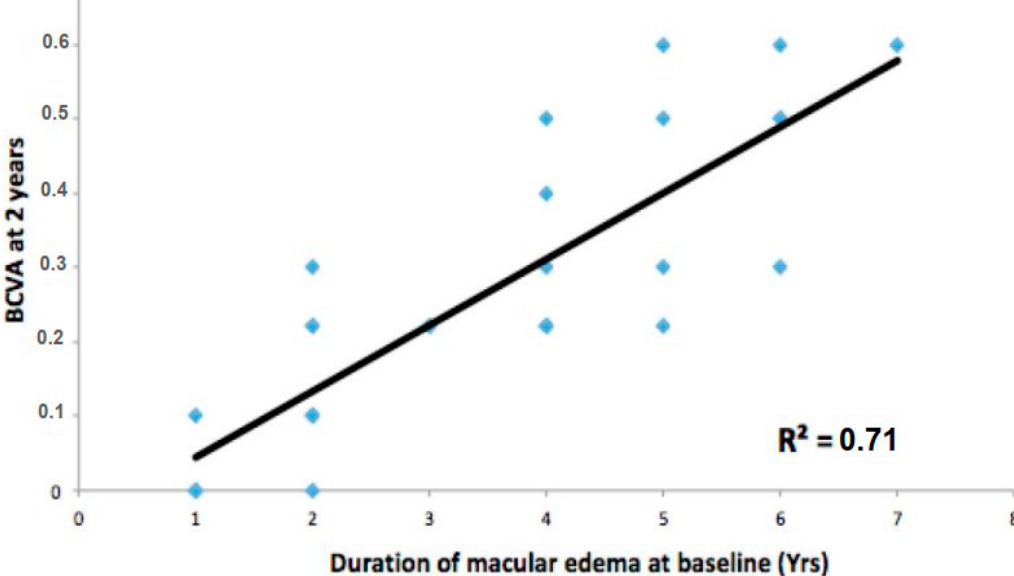
Figure 2. Pearson’s linear correlation between diabetes macular edema duration and final vision. By analyzing OCT patterns, 12 out of 28 patients (42.85%) had DME with subfoveal serous retinal detachment (SRD) at baseline. This subset of patients had better visual results at two years compared to patients who did not have subretinal fluid(SRD) (0.15 ± 0.1 and 0.33 ± 0.1, respectively) ( p = 0.001) (Figure